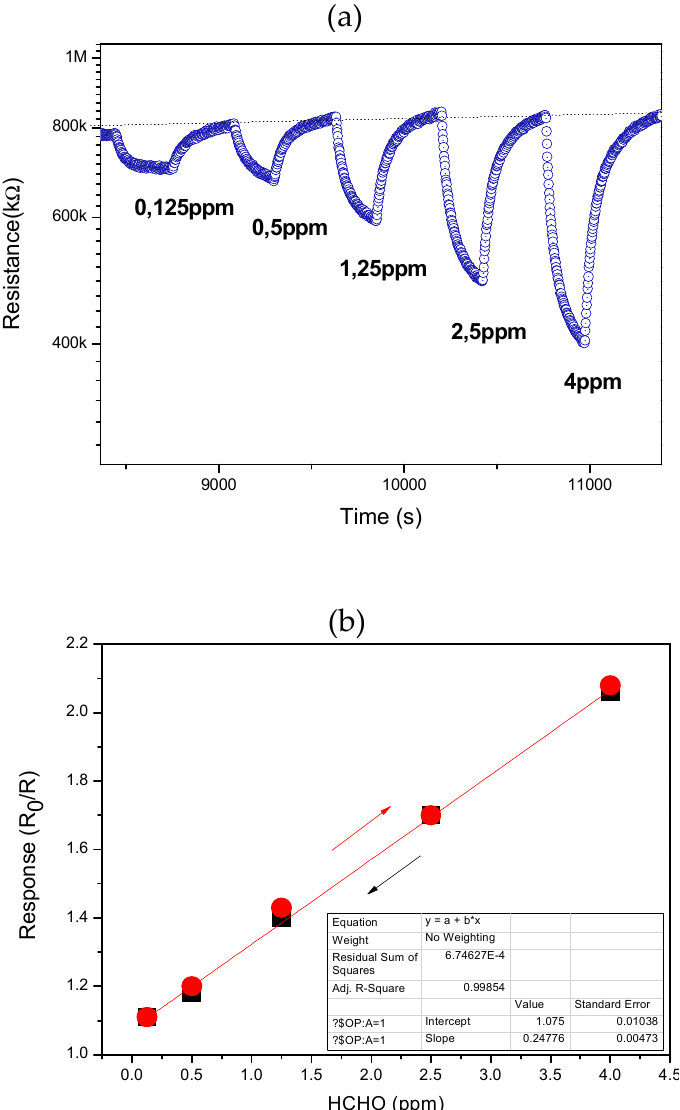
Figure 7. ( a ) Response of the 3Al,3Ca doped-ZnO sensor to different analyte concentrations, from 0.125 to 4 ppm; ( b ) Linear fit of response registered in the function of both increasing (red point) and decreasing (black point) HCHO concentration.